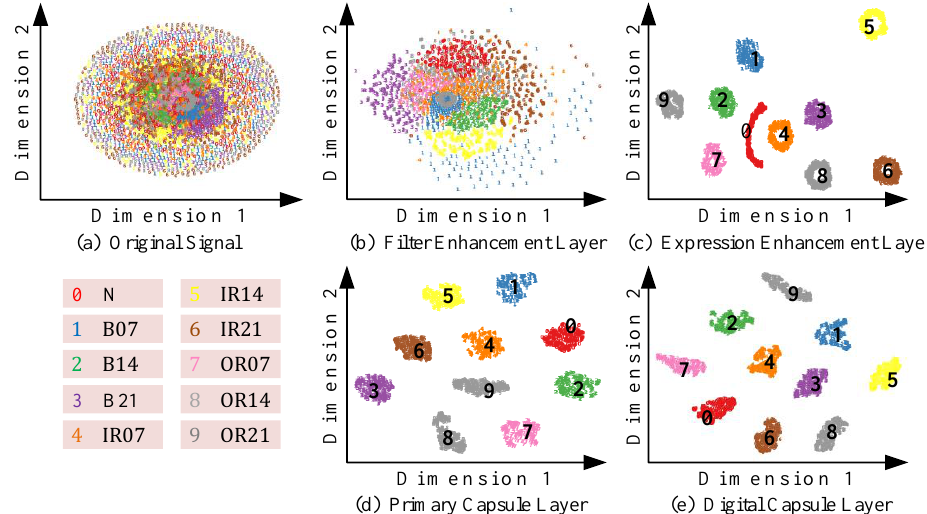
Figure 12. The visualization of the feature extraction process in EIFN. Here, 0–9 are labels for bearing status, where N represents normal state, B, IR, and OR represent ball, inner race, and outer race faults, respectively. The numbers represent fault diameters.